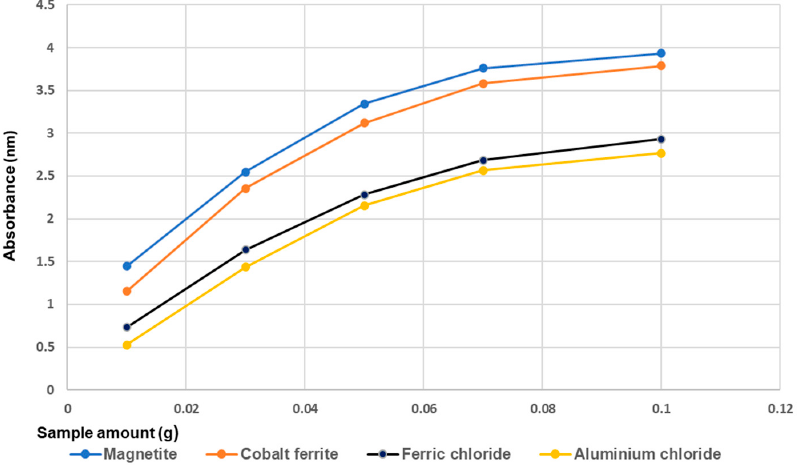
Figure 6. Comparison of different methods (coagulation agents vs adsorption on magnetic materi-